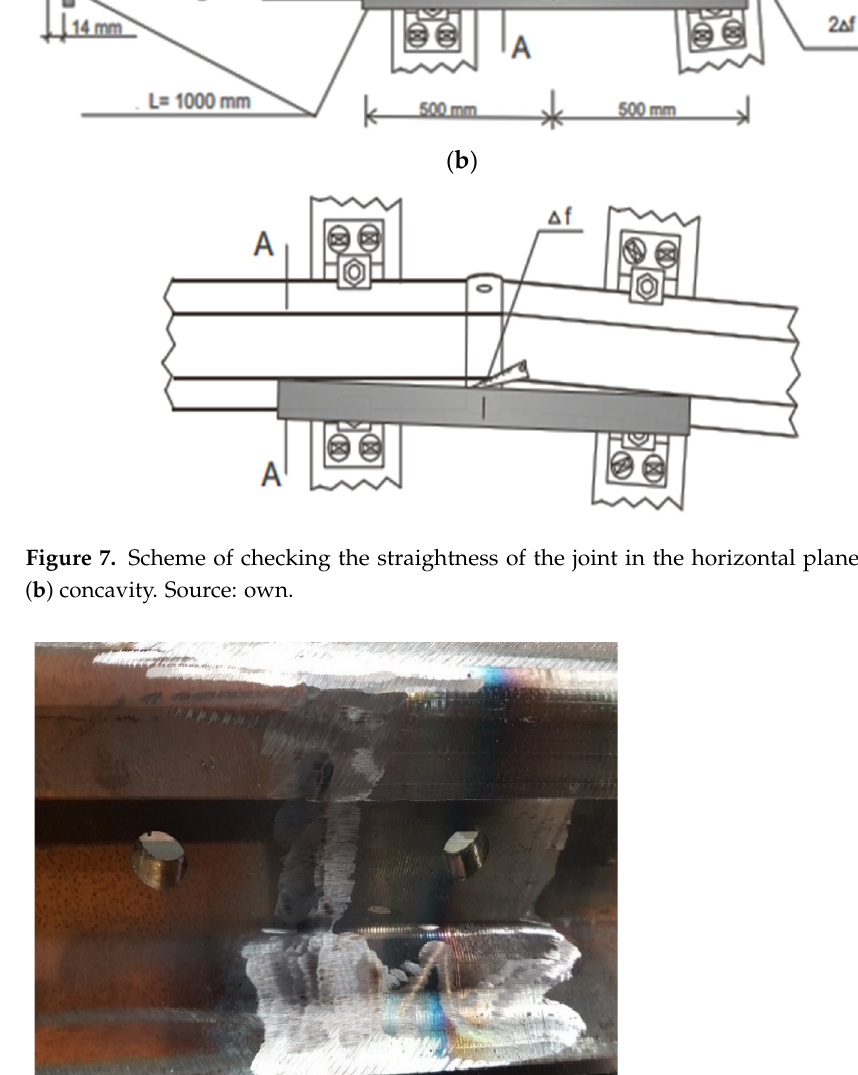
Figure 8. Needle weld. Source: